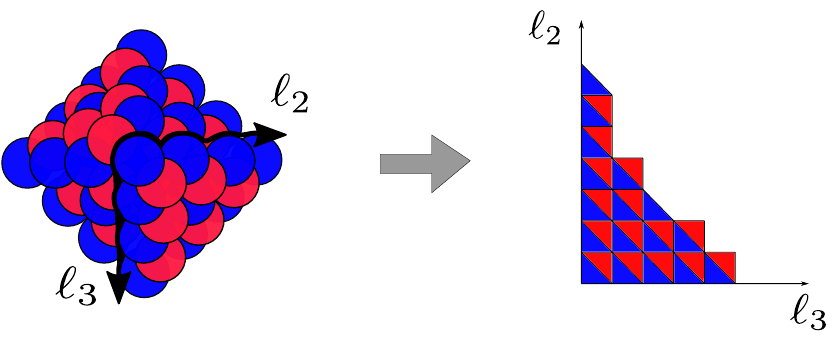
Figure 14. The lift up of the region R in the three-dimensional crystal. The right figure is a convenient way to draw the crystal shape in the plane.